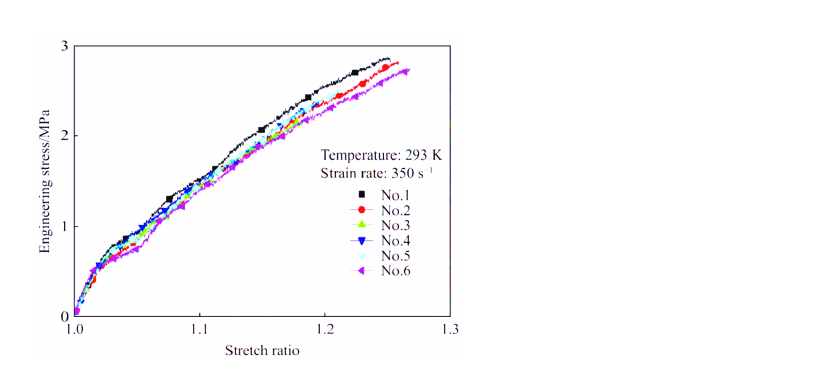
Figure 3. Elastic modulus of silica gel with different percentages glass fiber.